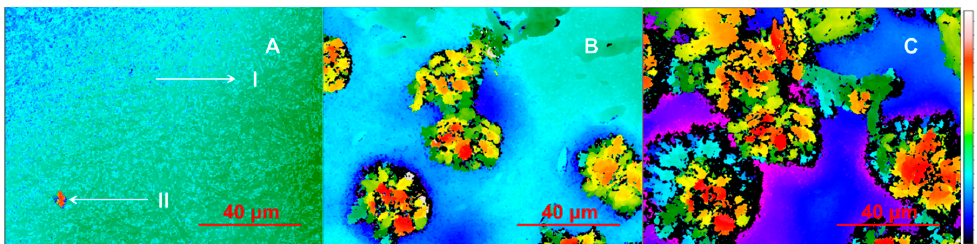
Figure 6. Time-lapse of wetting induced piroxicam (PRX) crystallization on the fixed surface of the tablet consisting of PRX-loaded hydroxypropyl methylcellulose (HPMC) nanofibers. The PRX release is visualized by scanning white light interferometry (SWLI). Key: ( A-I ) Initial state of the tablet; ( A-II ) After wetting with 2 µ L of water and evaporating for 1 min; ( B ) After wetting a second time with 2 µ L of water and evaporating for 10 min; ( C ) After wetting a third time with 2 µ L water and evaporating for 10 min. The scale for height di ff erences is changed according to changes in surface altitude (A—0 to 8 µ m; C—0 to 90 µ m). The diameter and thickness of tablet (disc) are 12.7 mm and 0.8–1.0 mm, respectively. Magnification 30 ×